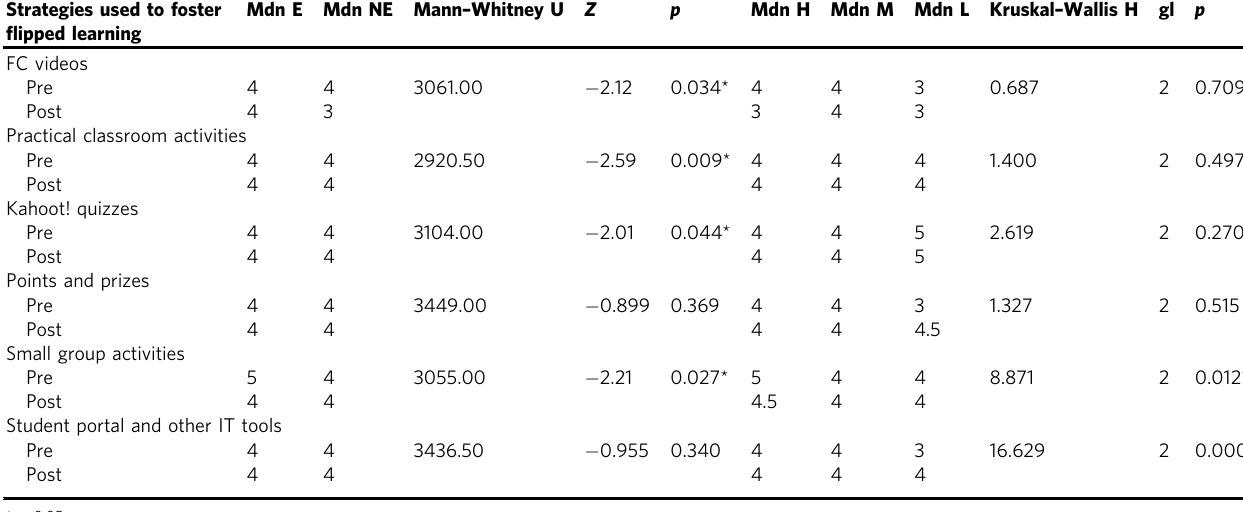
Table 8 Non-parametric results for the variables referring to the evaluation of the strategies used to foster their learning in this approach during the COVID-19